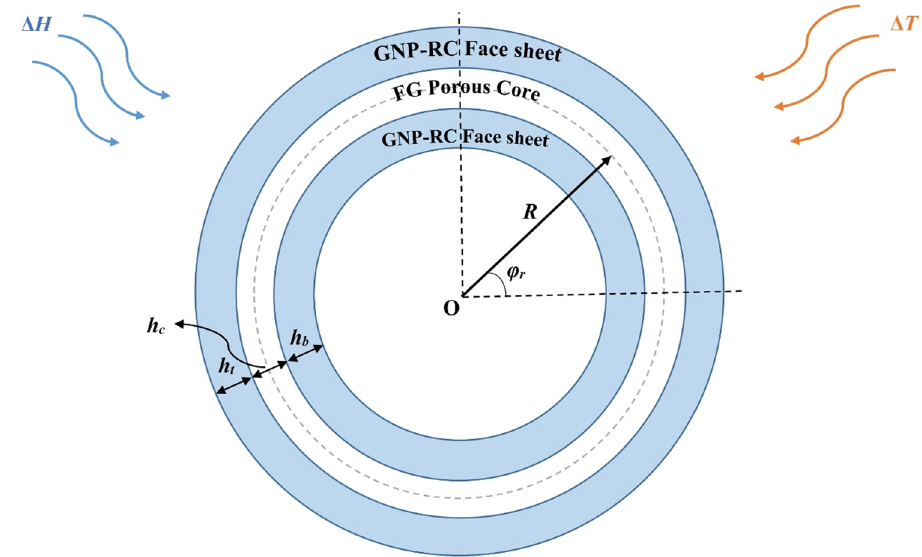
Figure 1: Cross - section view of the sandwich cylindrical shell subjected to hygrothermal